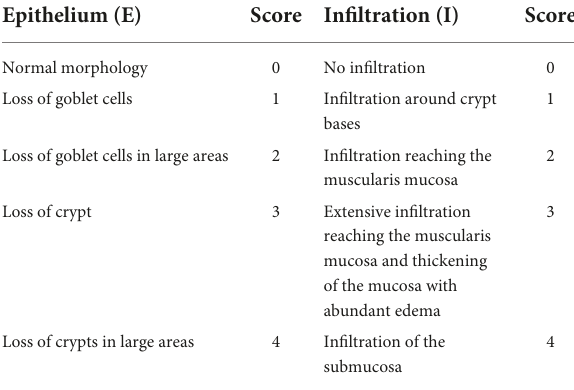
TABLE 2 Evaluation of histological